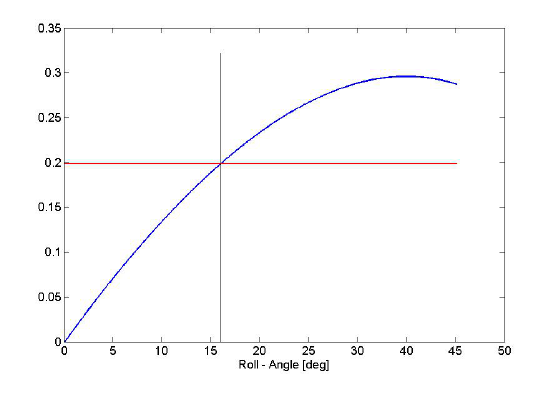
Figure 2: Roll angle α